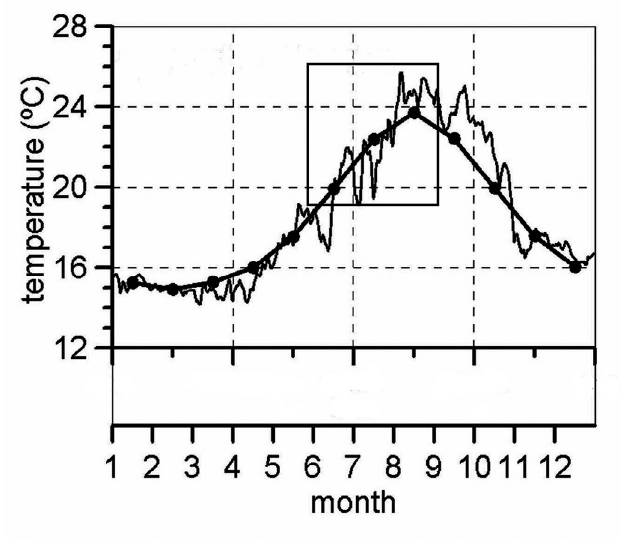
Fig. 5. – Mean daily SST for the northern zone of the Alboran Sea in 2018 and monthly mean values for the period 1981-2021 (line with points). The rectangle highlights the biological sample (June to September).